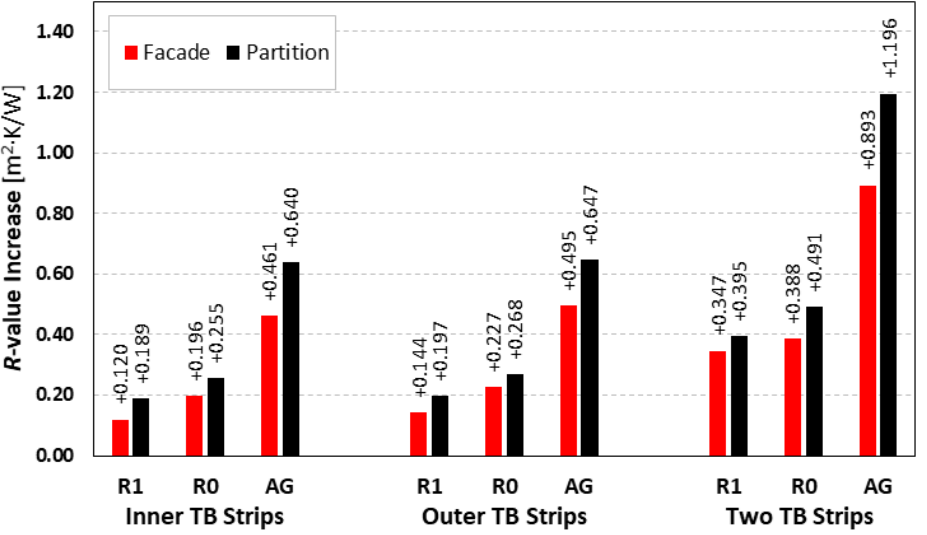
Figure 11. The increase in thermal resistances due to thermal break (TB) strips’ use in load-bearing LSF walls: facade vs partition [30].